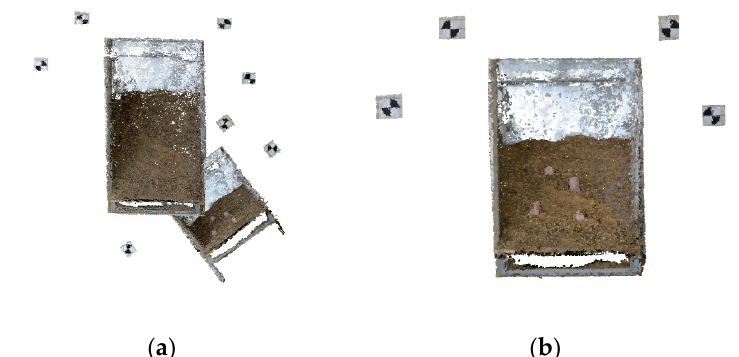
Figure 13. Results before and after the geodetic control point registration. ( a ) The position and distribution of data before the geodetic control point registration, and ( b ) The data after the geodetic control point registration.